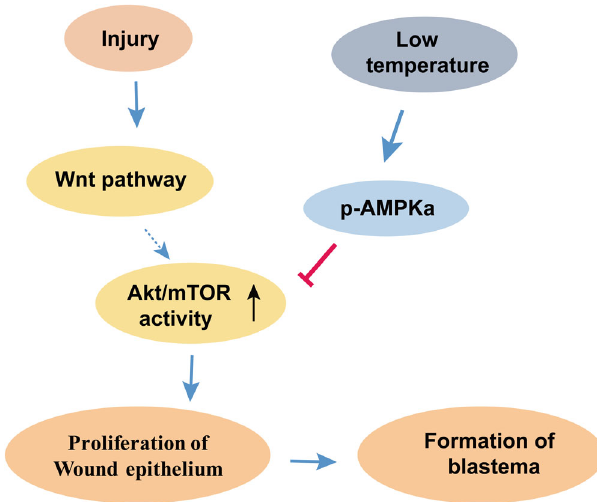
Fig. 8 Schematic representation of working model. Schematic illustration of the Wnt pathway and low temperature regulated formation of wound epithelium and blastema. In response to tail shedding in the geckos, Wnt pathway is activated and then enhances the activity of Akt/mTOR. In condition of low temperature, the metabolic level of gecko decreases thus activates the AMPK activity, which in turn restrains the activity of mTOR. The increased Akt/mTOR activity is necessary for the proliferation of wound epithelium and formation of